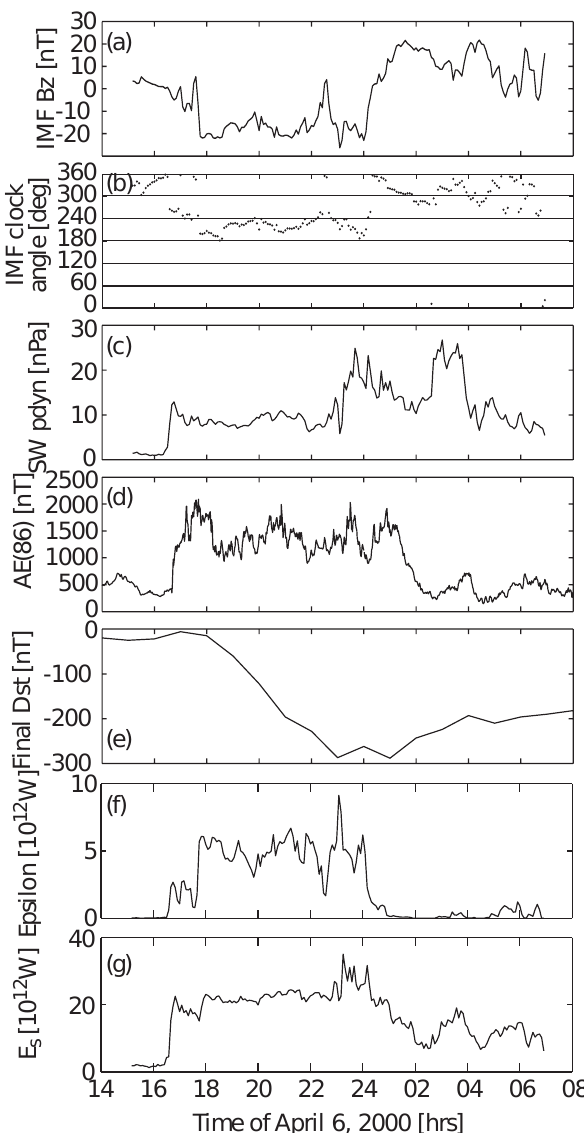
Fig. 1. Solar wind conditions during the April 2000 storm. (a) IMF B z , (b) IMF clock angle, (c) solar wind dynamic pressure, (d) AE index measured at 86 stations, (e) final D st index, (f) (cid:15) calculated from the solar wind parameters, and (g) total energy through the magnetopause